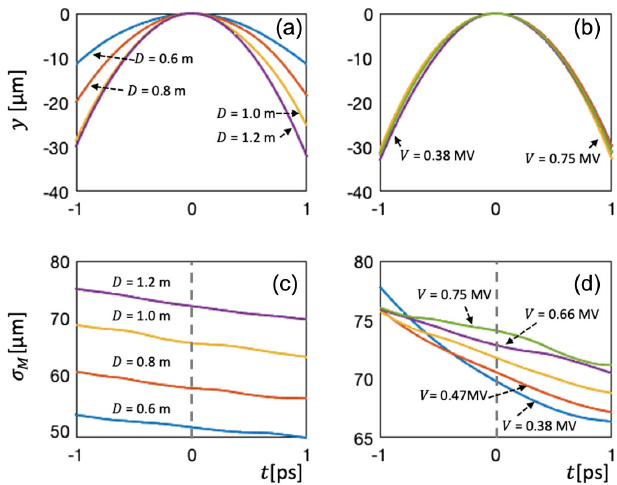
FIG. 12. Measured curves with the dispersion scan method. Mean vertical position of the slices y on the screen along the bunch for different dispersion values are shown in (a). Mean vertical position of the slices on the screen along the bunch for different TDS voltages are shown in (b). Vertical size of the slices on the screen along the bunch for different dispersion values are shown in (c). Vertical size of the slices on the screen along the bunch for different TDS voltages are shown in (d). The gray dotted lines present the position of the reference slice.